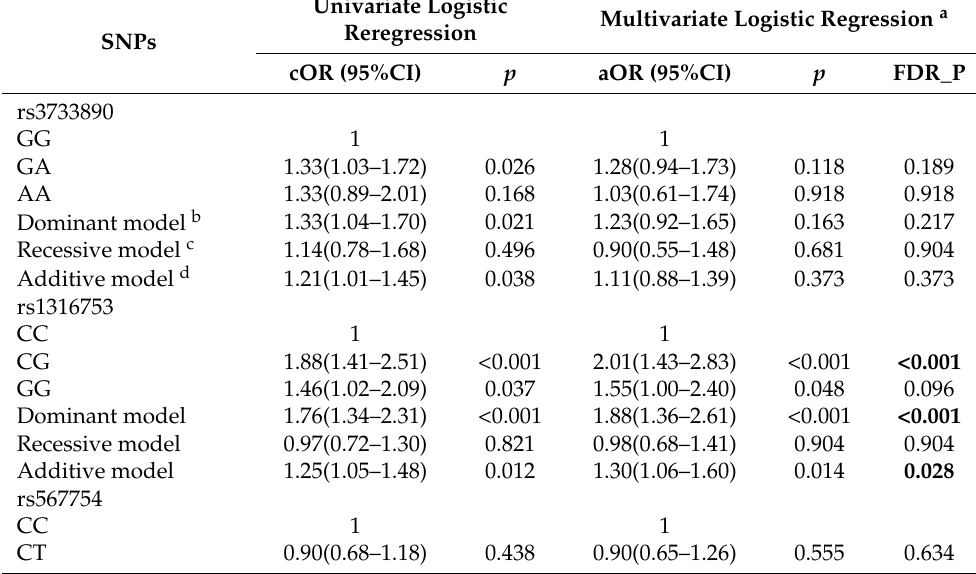
Table 4. Polymorphisms of maternal BHMT gene associated with risk of VSD in offspring based on logistic regression